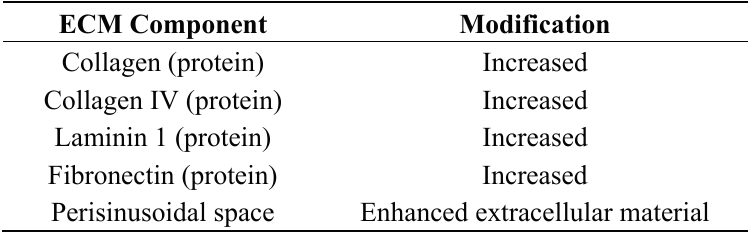
Table 3. Liver ECM alterations in chronic vitamin A